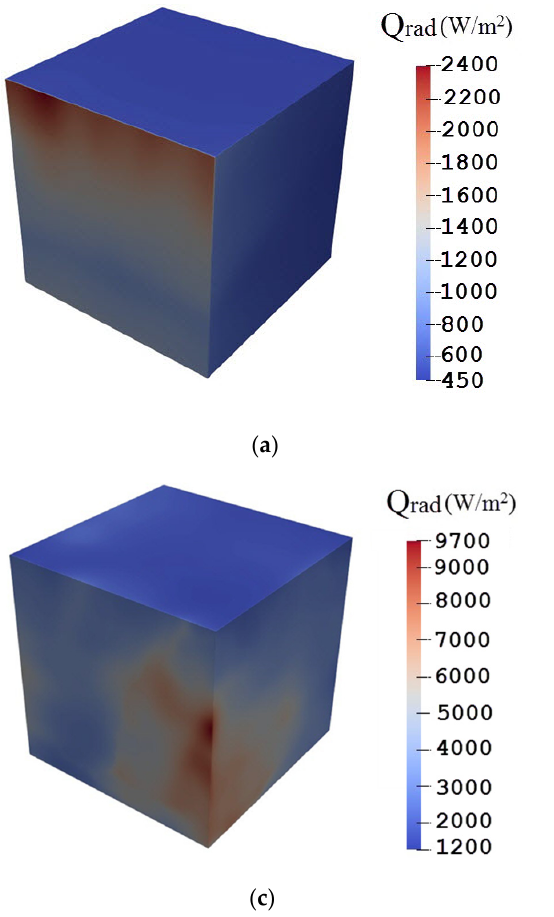
Figure 7. Instantaneous radiative heat flux at different times: ( a ) t = 5 s, ( b ) t = 10 s, ( c ) t = 15 s, ( d ) t = 20s.